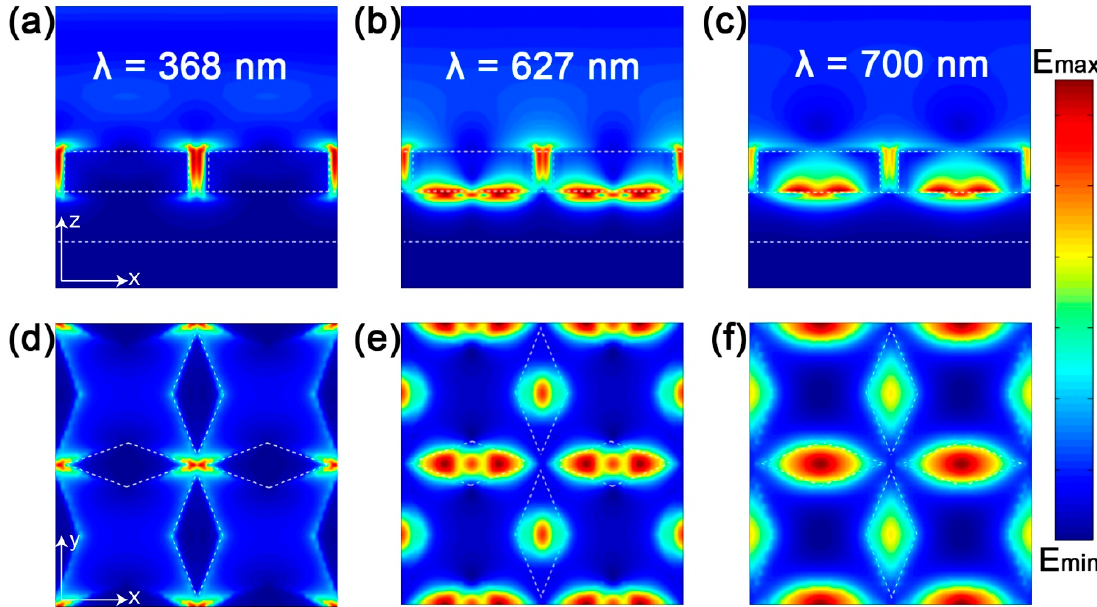
Figure 4. Corresponding electric field distribution at 368 nm, 627 nm and 700 nm, where ( a – c ) is the electric field intensity distribution in the xoy plane, and ( d – f ) is the electric field intensity distribution in the xoz plane.